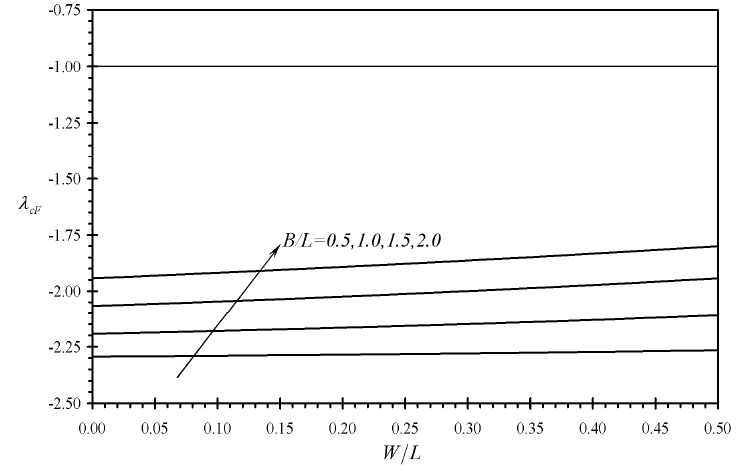
Figure 6. Effects of the relative dimensions of the microcantilevers assemblies (b) and (c) on the second performance indicators λ